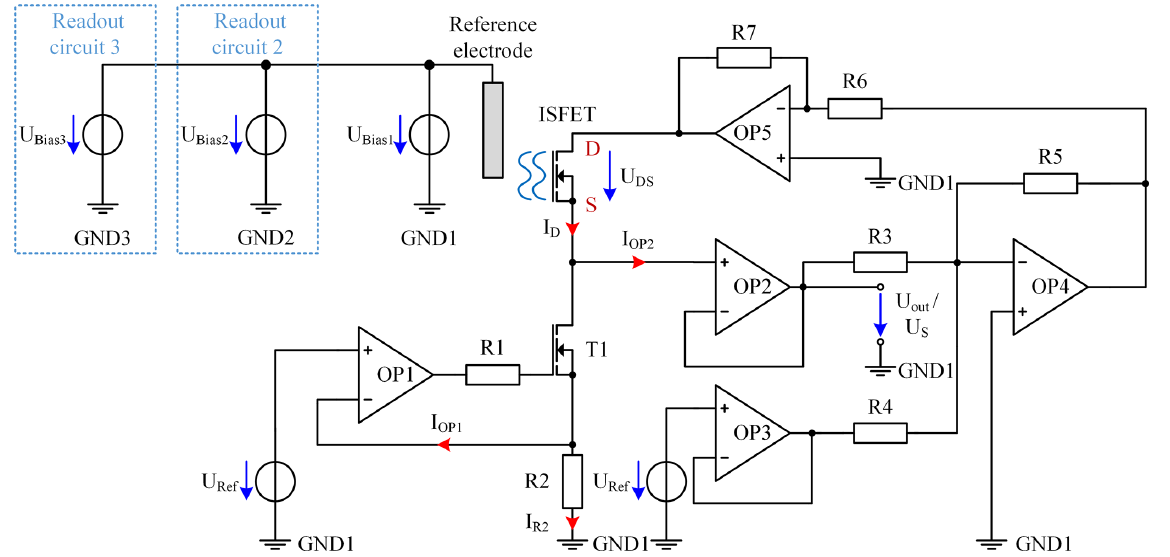
Figure 9. Schematic of the ISFET readout circuit for one ISFET with TL072 OPs. In addition, the bias voltages U Bias2 and U Bias3 are shown for the additional two independent readout